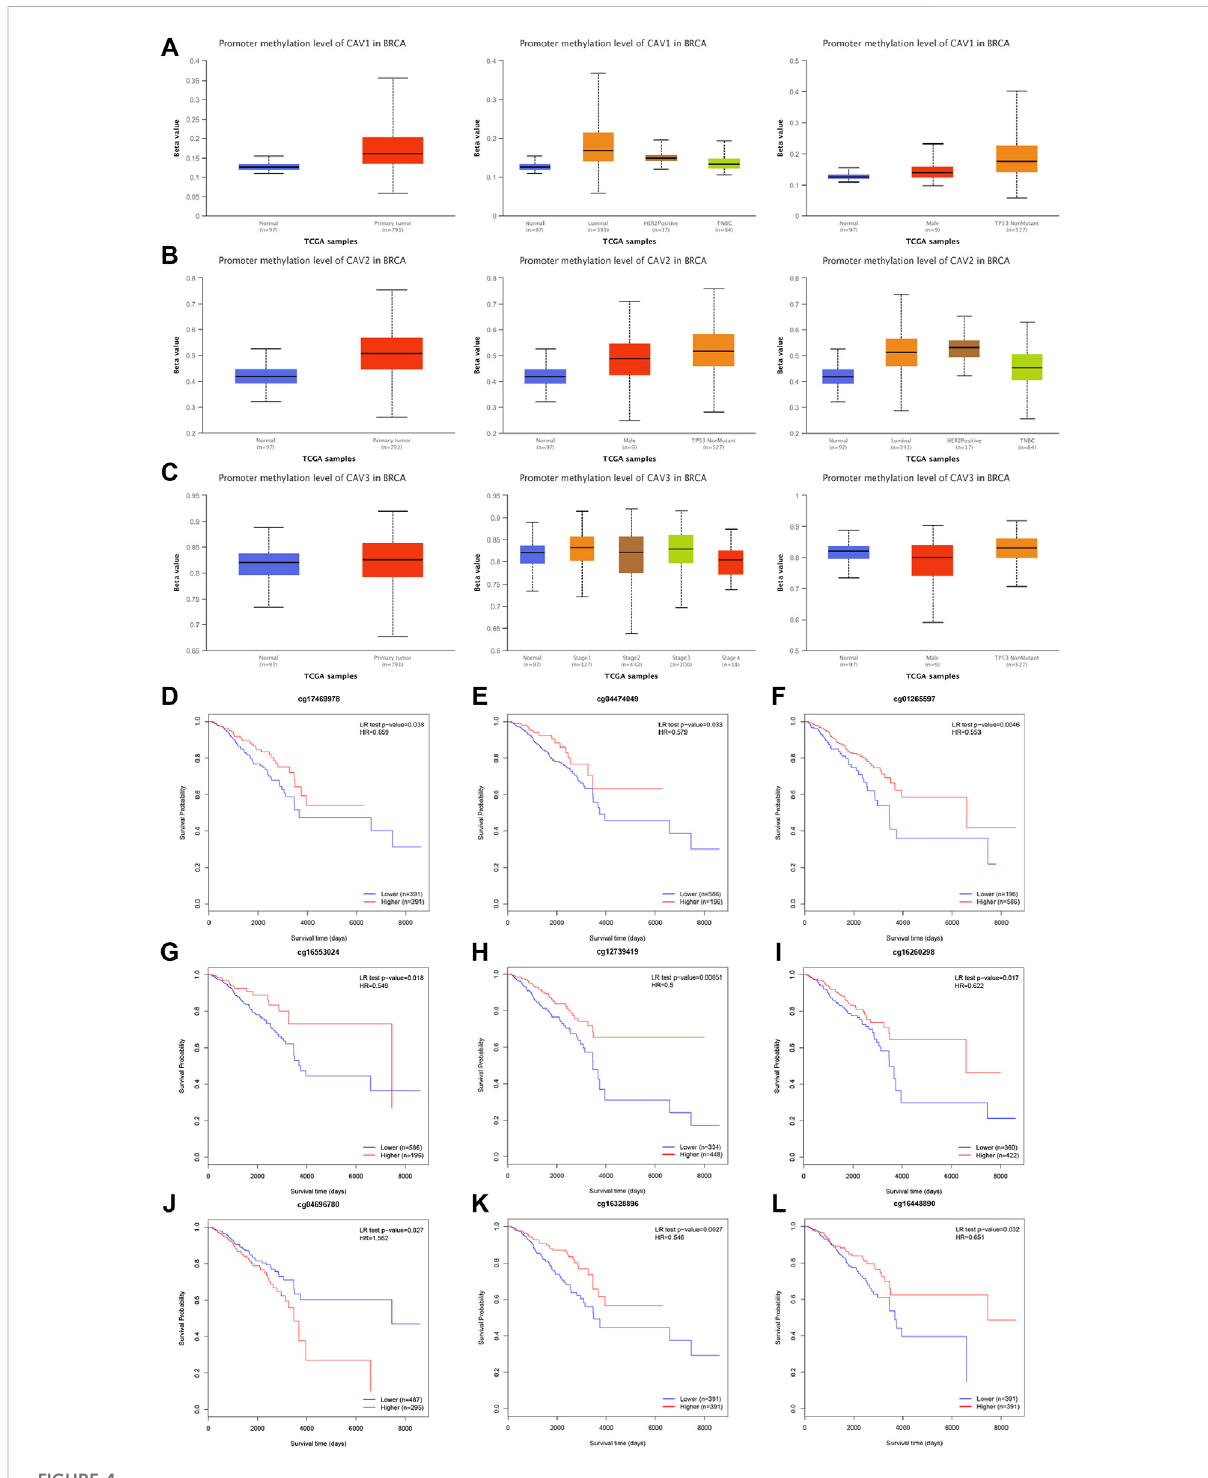
FIGURE 4 DNAmethylationlevelofCAVpromoterscorrelatedwiththeprognosisofBC. (A – C) CAV1andCAV2werehypermethylatedinBCtissues. (D – L) Prognostic value of CAVs – speci fi c CpG site methylation in